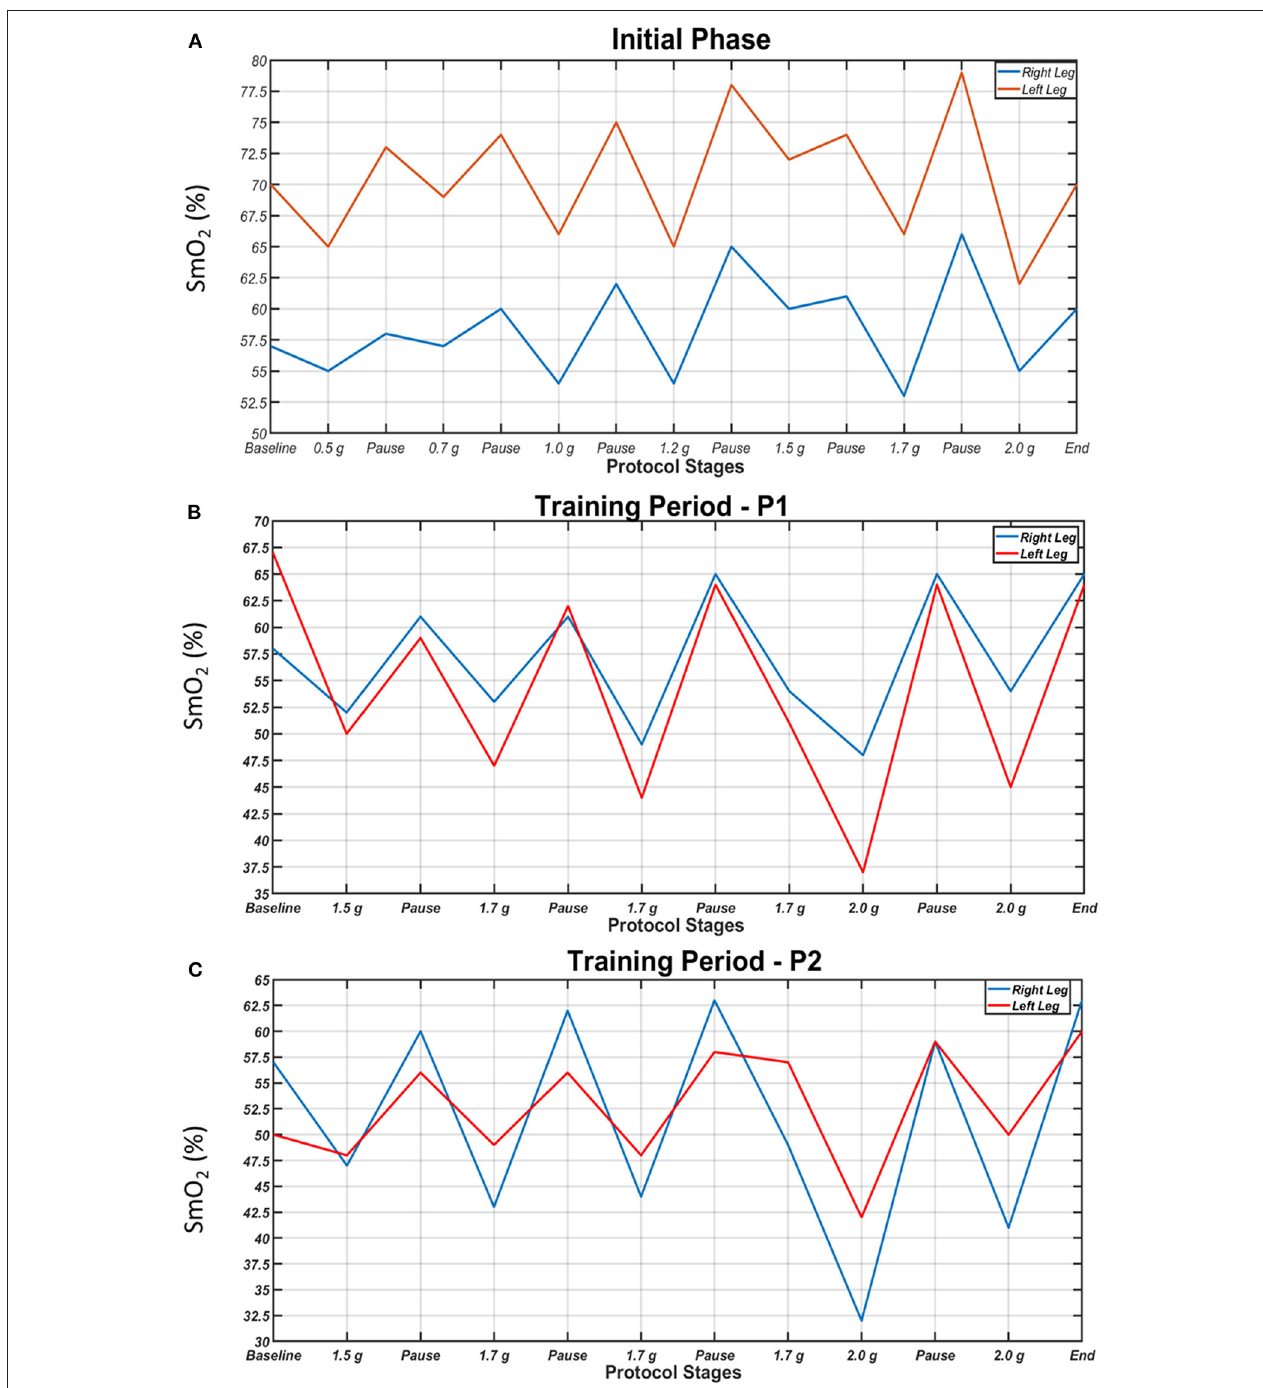
FIGURE 5 | Oxygen saturation of the gastrocnemius medialis muscles (SmO 2 ) of the right (blue) and left leg (red) during each step of the initial centrifugation test (A) , a session in the 1st period (B) and a session in the 2nd period of the study (C) . SmO 2 dropped during centrifugation and increased during pauses. Higher g values generally resulted in lower SmO 2